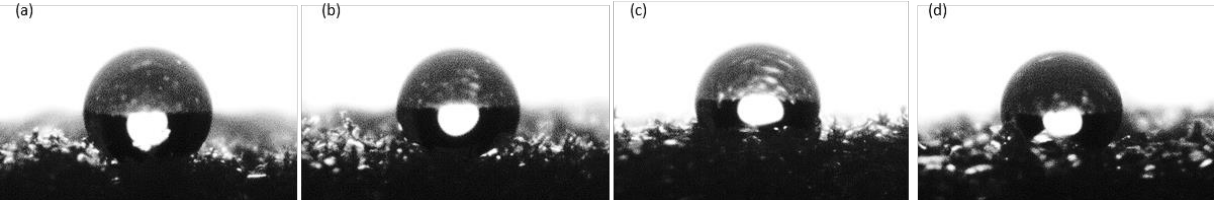
Figure 11. The images of contact angles measured for ( a ) PUR_REF, ( b ) PUR_L, ( c ) PUR_L_K, and ( d ) PUR_L_HA.